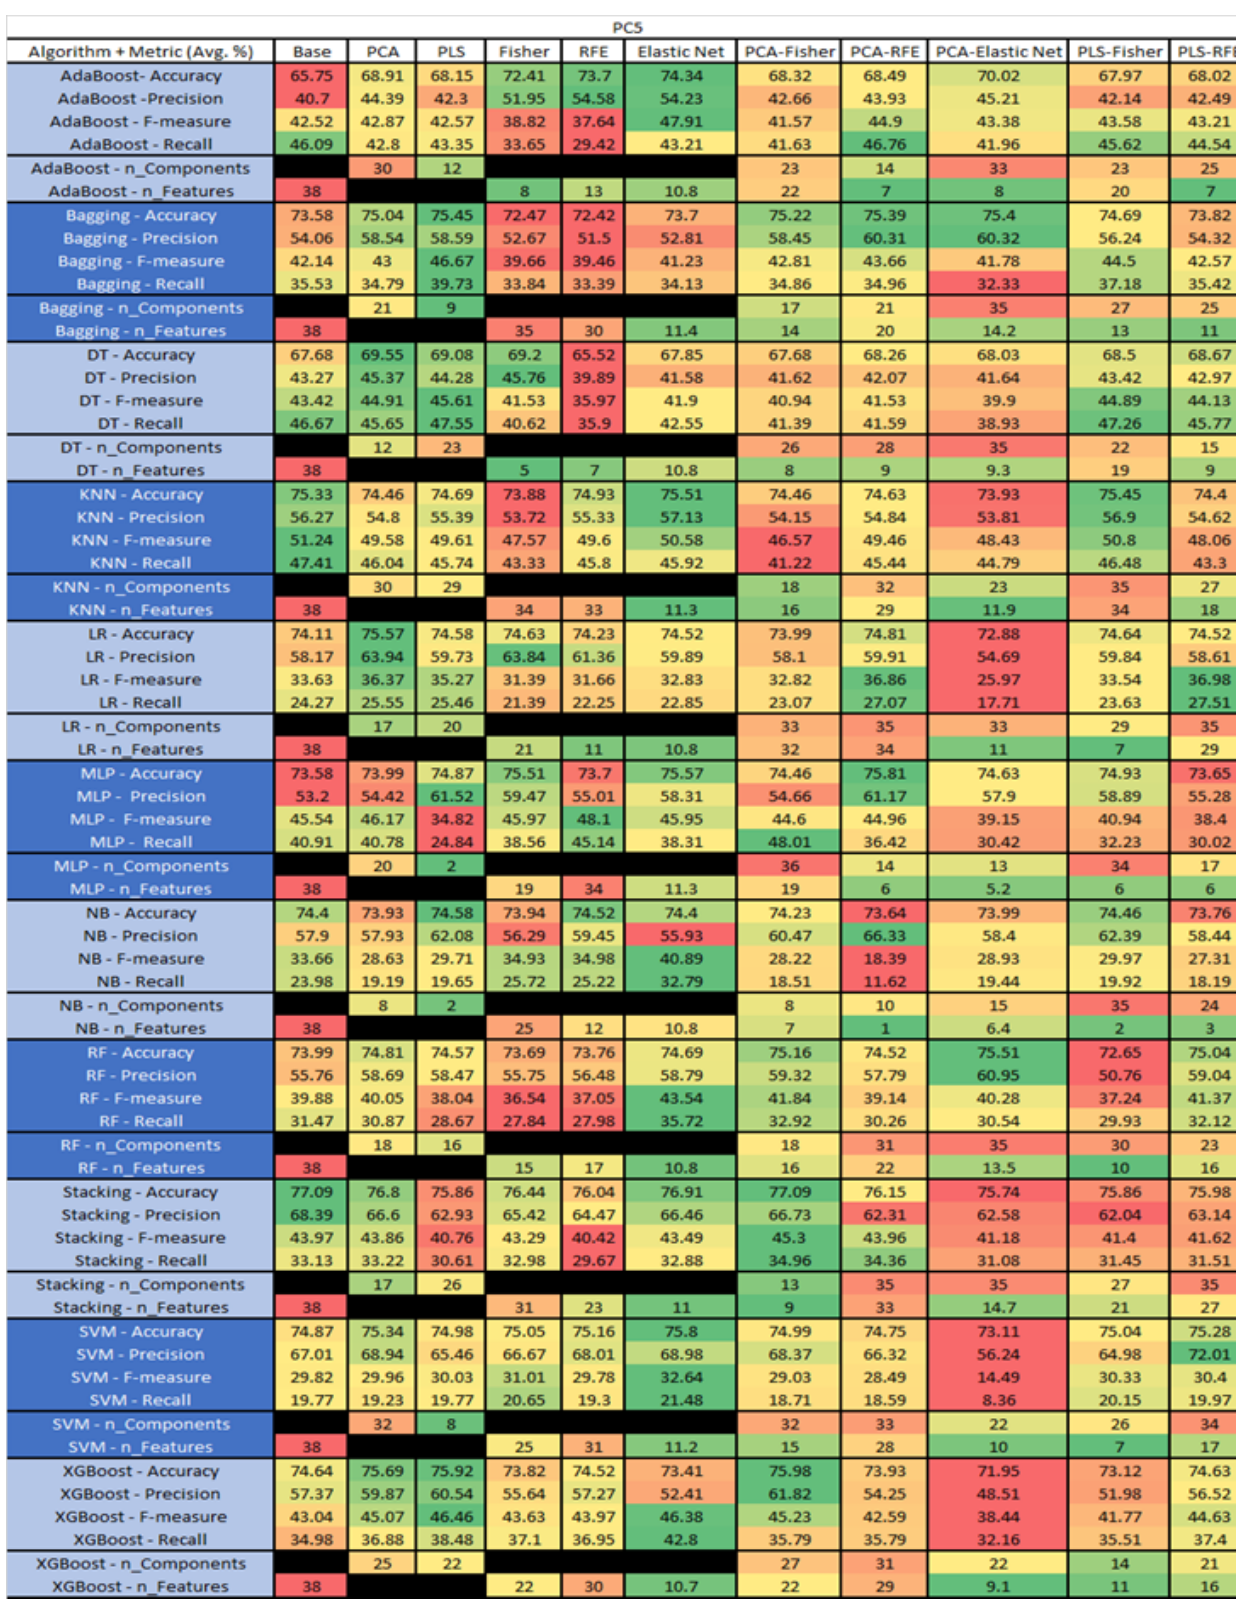
Figure 48. PC5 NASA MDP Results Data